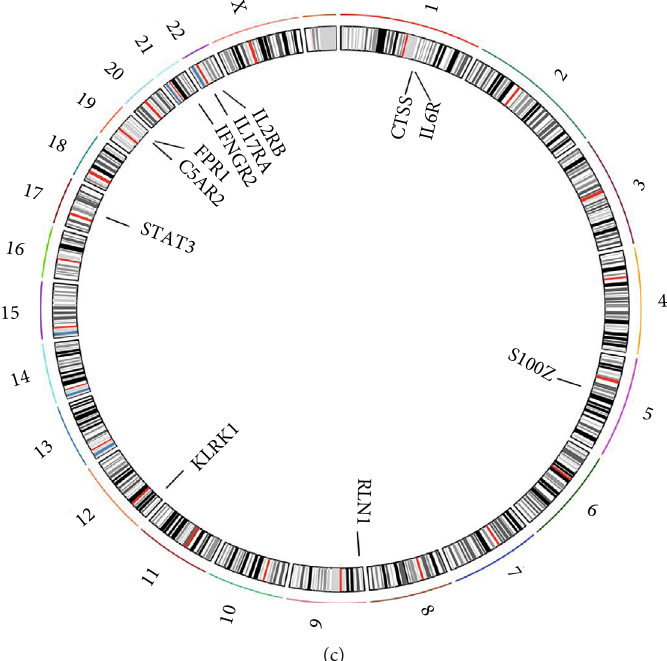
Figure 1: (a) Expression heat map of the 11 IRGs in non-disc degeneration and degeneration patients. (b) Di ff erential expression histogram of the 11 IRGs identi fi ed between nondisc degeneration and IDD patients. (c) Chromosomal positions of the 11